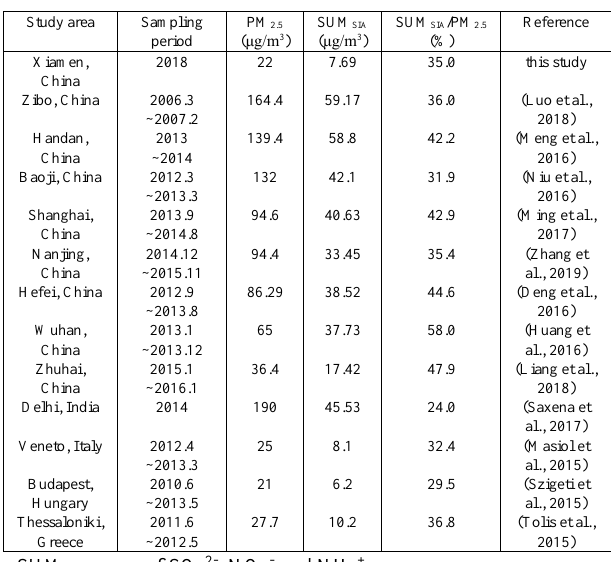
Table 3. Comparisons of PM 2.5 , SUM SIA concentrations in other cities